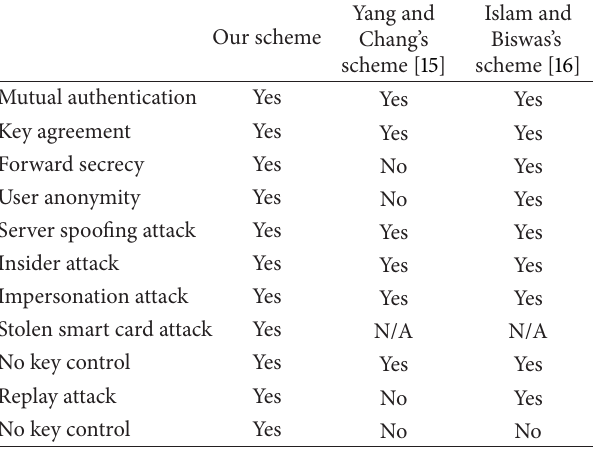
Table 2: Security properties comparison. Yang and Islam Our scheme Chang’s scheme [15]